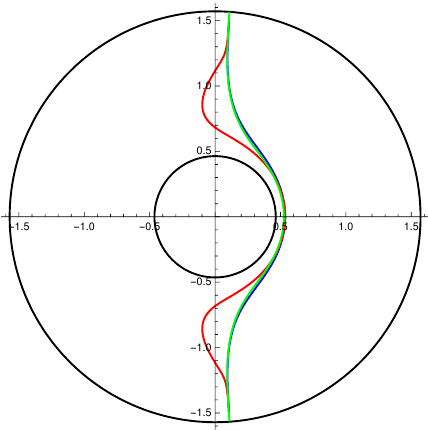
Figure 9. Causal information surface (cid:4) A constructed by shooting the fastest mode of propagation (Red). The equivalent of the causal information surface if one shoots conventional null rays instead of the fastest mode (Blue). Entanglement minimal surface (cid:0) A (Green). We have set (cid:21) = 0 : 2, r h = 0 : 5, and (cid:30) A = 1 :